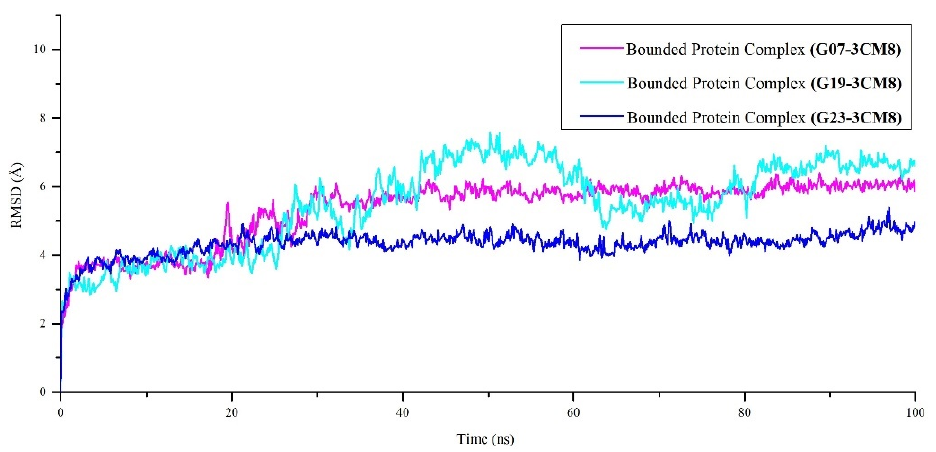
Figure 9. The RMSD curves of G07 -3CM8, G19 -3CM8 and G23 -3CM8 during 100 ns simulations.